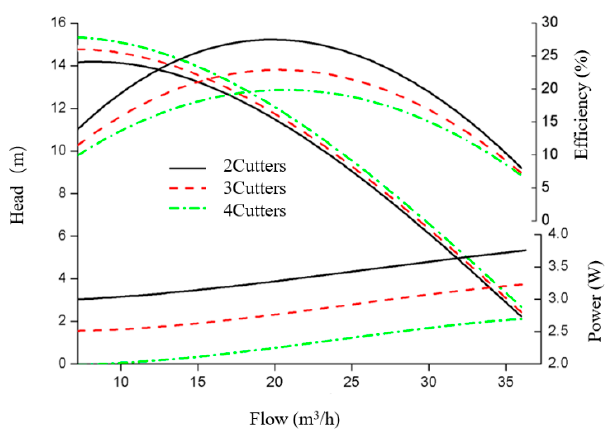
Figure 14. Pump performance curve with different numbers of cutter heads.